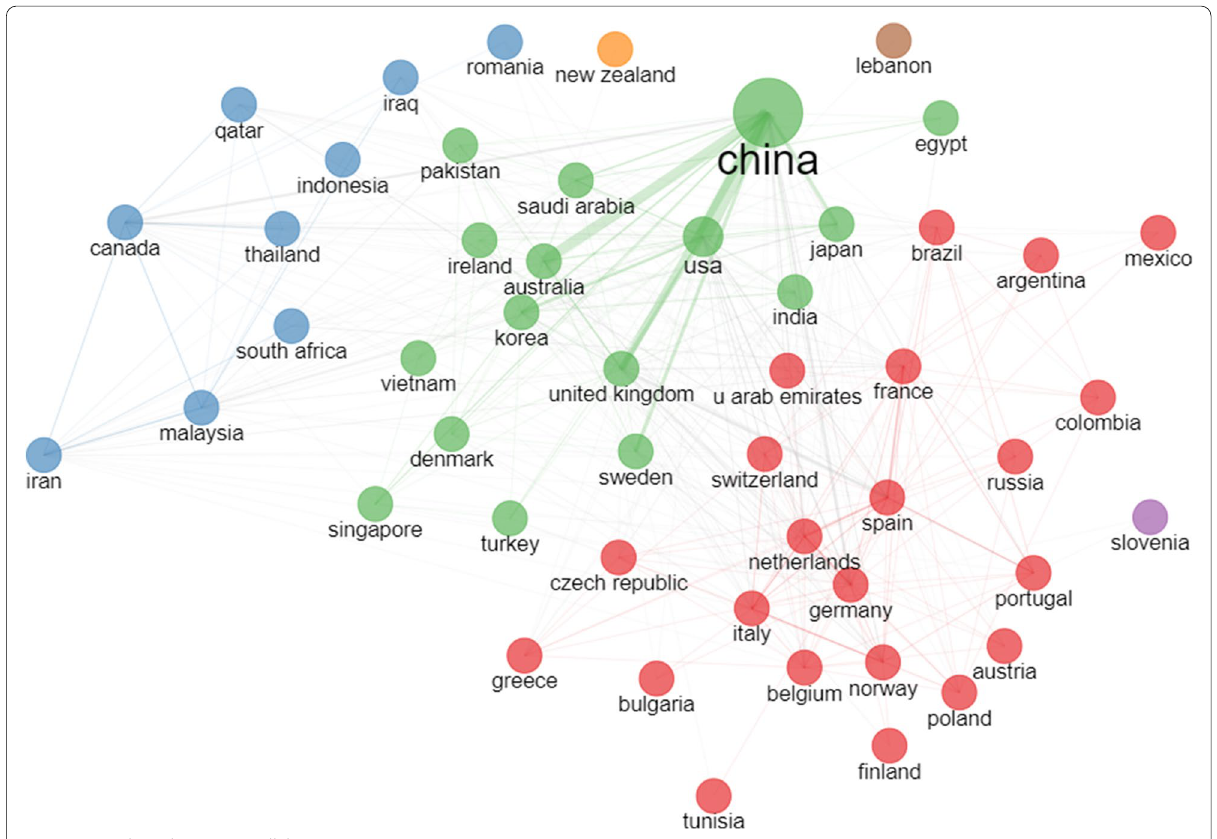
Fig. 33 Combined, country collaboration map